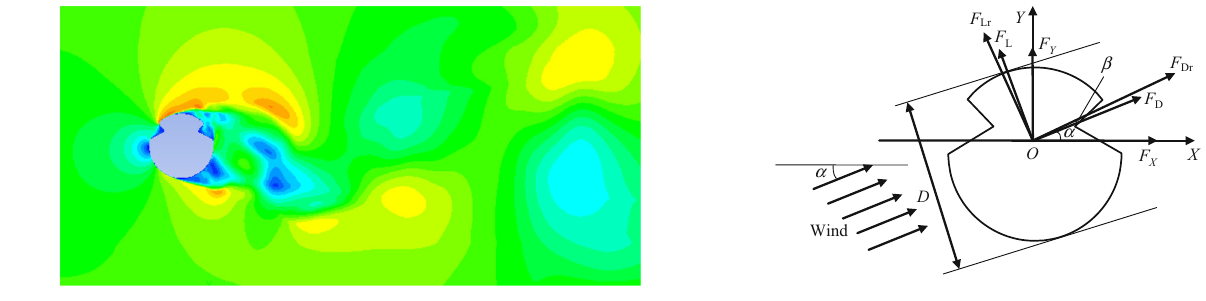
Fig. 8 Upwind section of